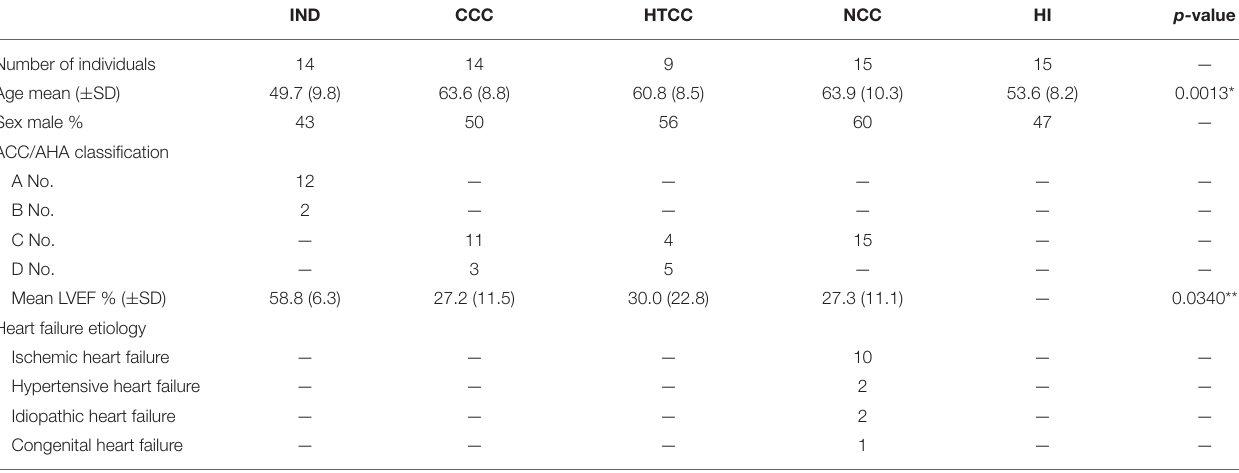
TABLE 1 | Demographic and clinical characteristics of patients and individuals enrolled in the study. IND